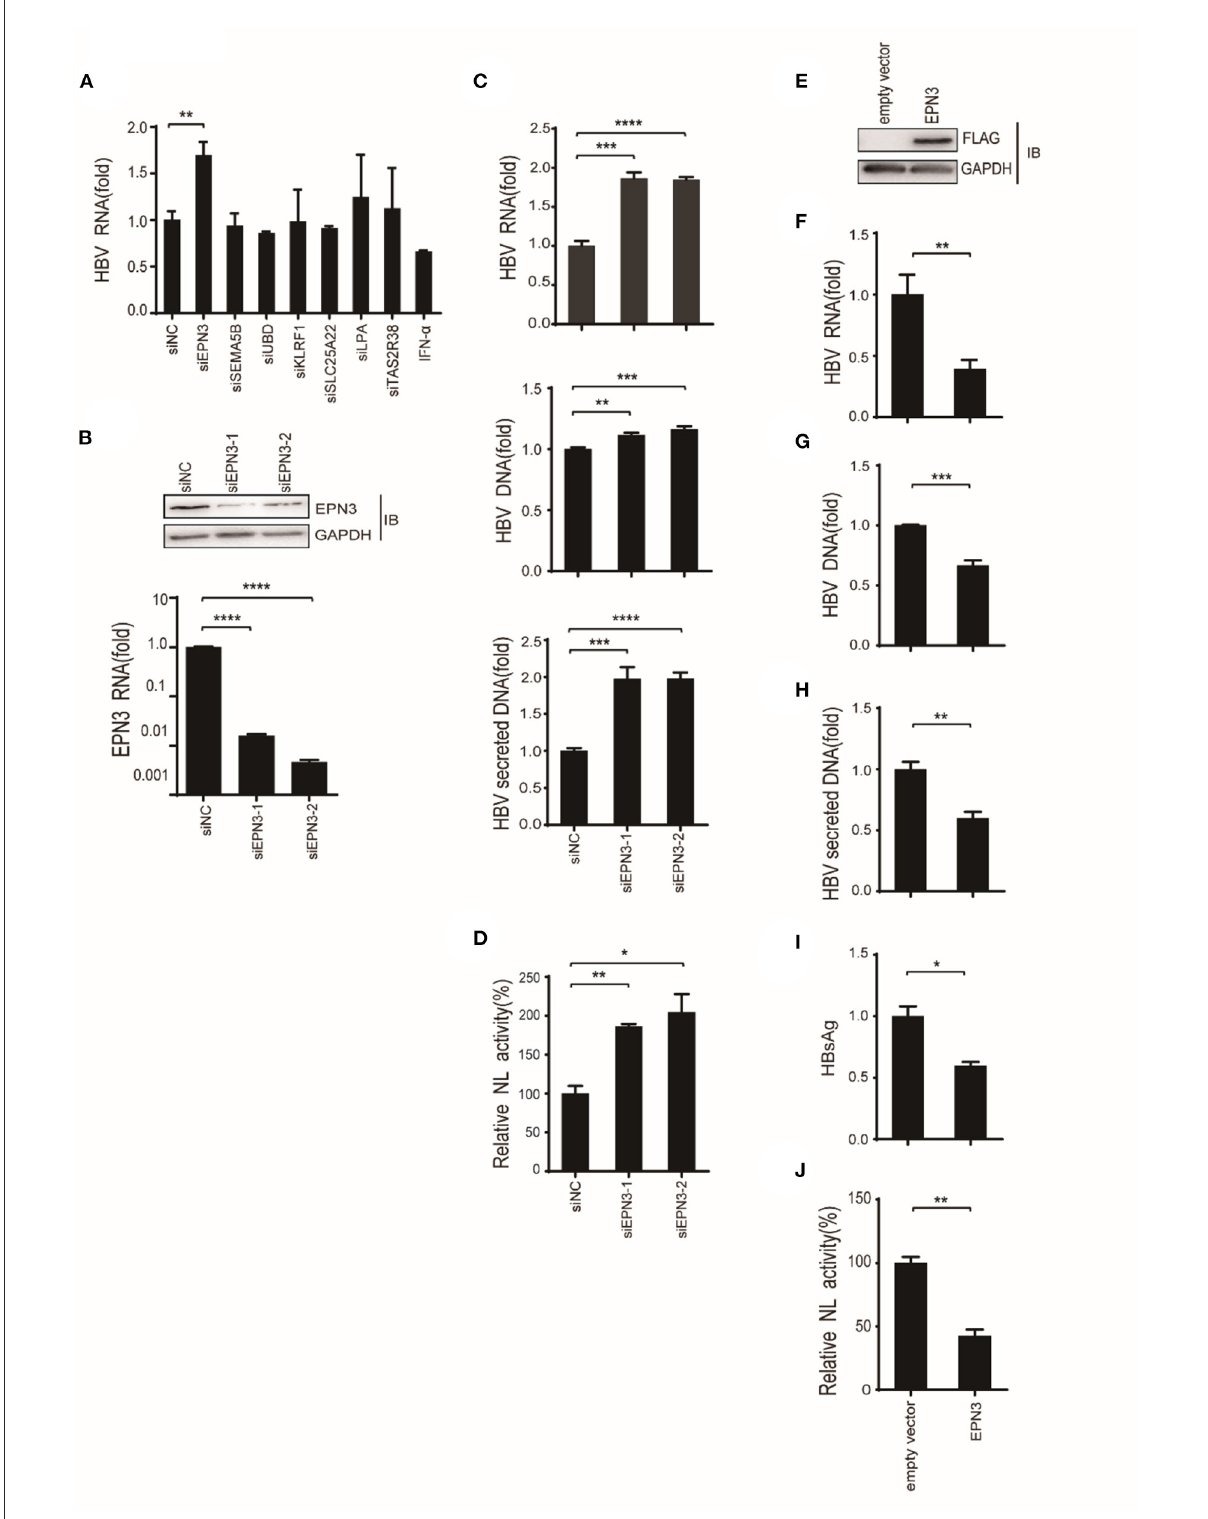
FIGURE2 EPN3 negatively regulates the expression of HBV RNA. (A–C) Huh7 cells were transfected with pPB and the indicated siRNAs or the negative control (siNC), and 3 days later, the cells and supernatants were harvested. ( A,B bottom, C top) HBV RNA and EPN3 mRNA were quantified